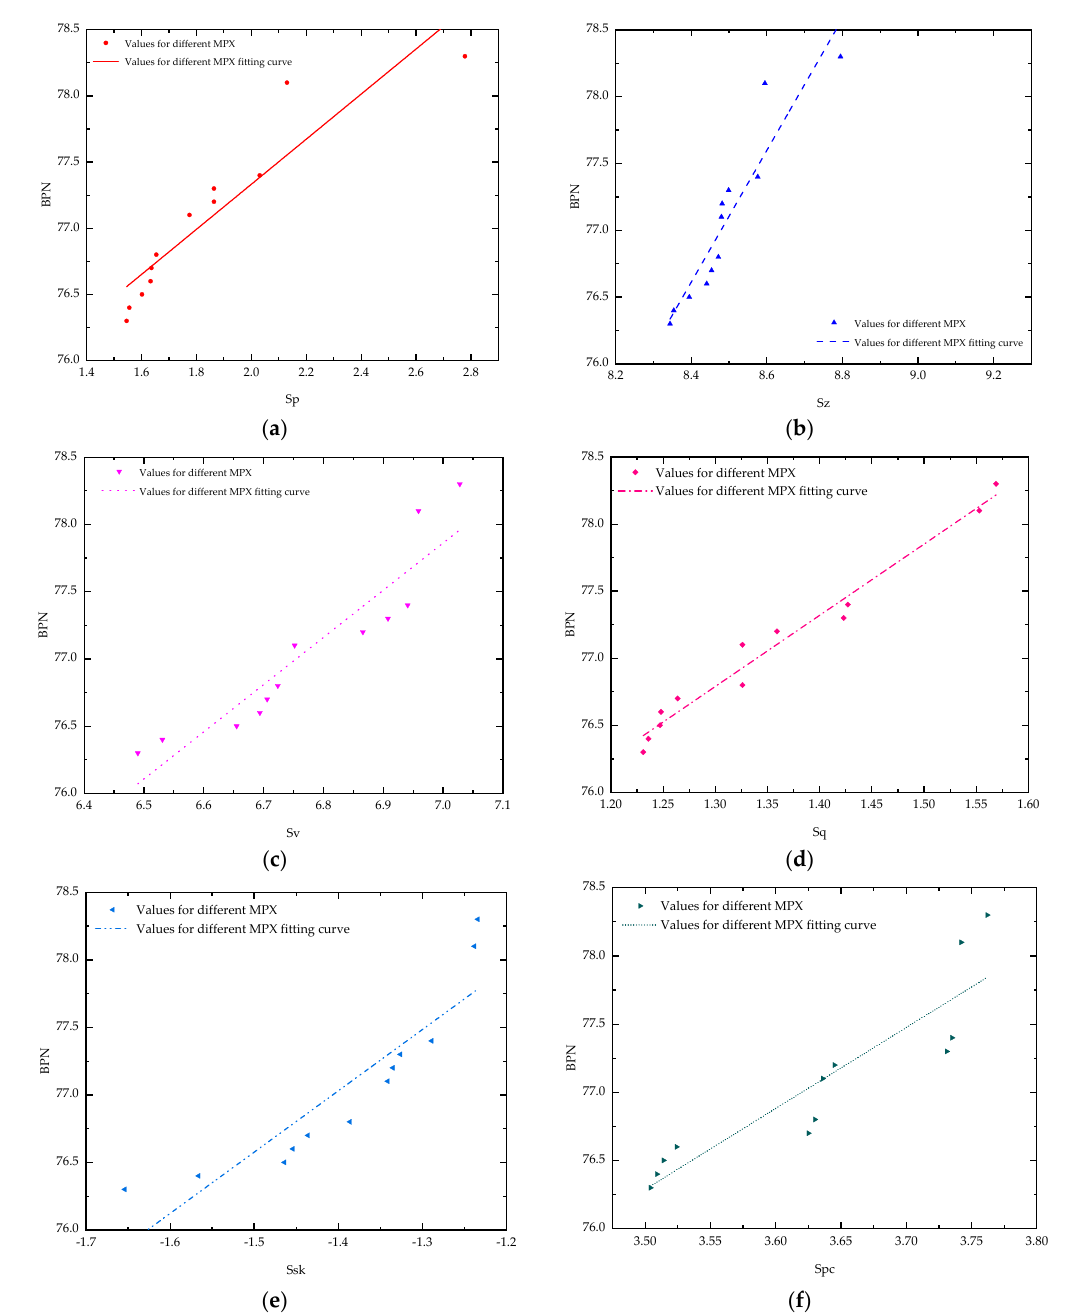
Figure 20. Regression analysis of initial 3D texture parameters of pavement and British pendulum: Table 11. Fi tt ing parameters of initial 3D texture parameters of pavement and British pendulum.